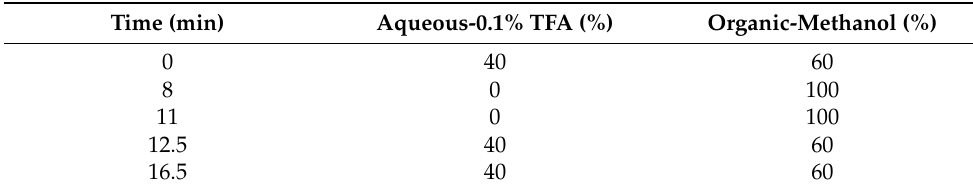
Table 2. Gradient elution for gossypol